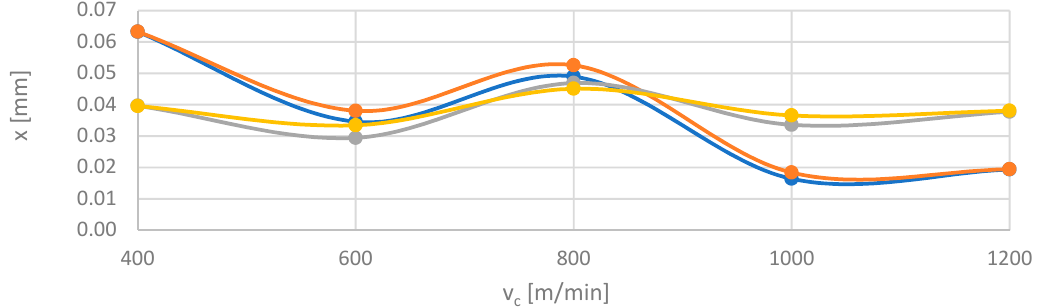
Figure 15. Comparison of experimental and numerical results depending on the cutting speed v c for trochoidal step s tr = 15% for vibrations displacement x in milling of AZ31 and AZ91D alloys. The numerical results obtained from simulations exhibit an acceptable level of error, below 15%.